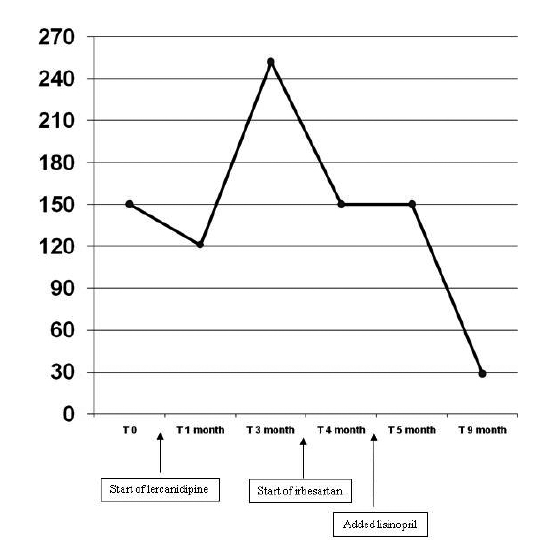
Fig. 1. Urinary albumin levels over the treatment period.